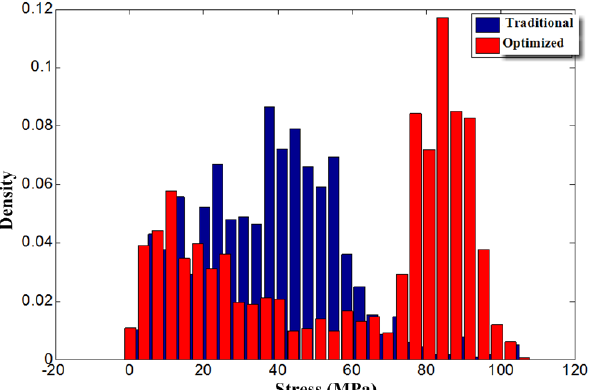
Figure 11. Stress distribution density of traditional and optimized flange.